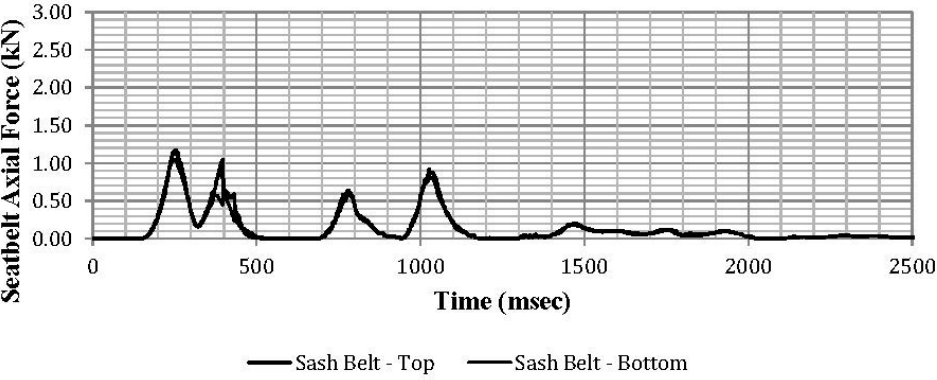
Figure A31. ATD Position 1 sash belt axial force.